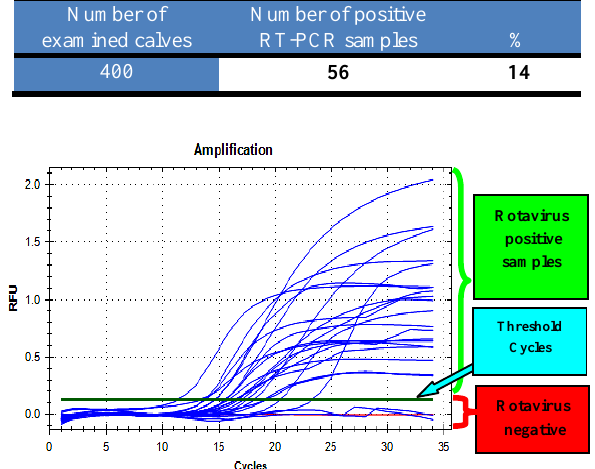
Table, 2: Rotavirus infection rate in examined diarrheic calves.